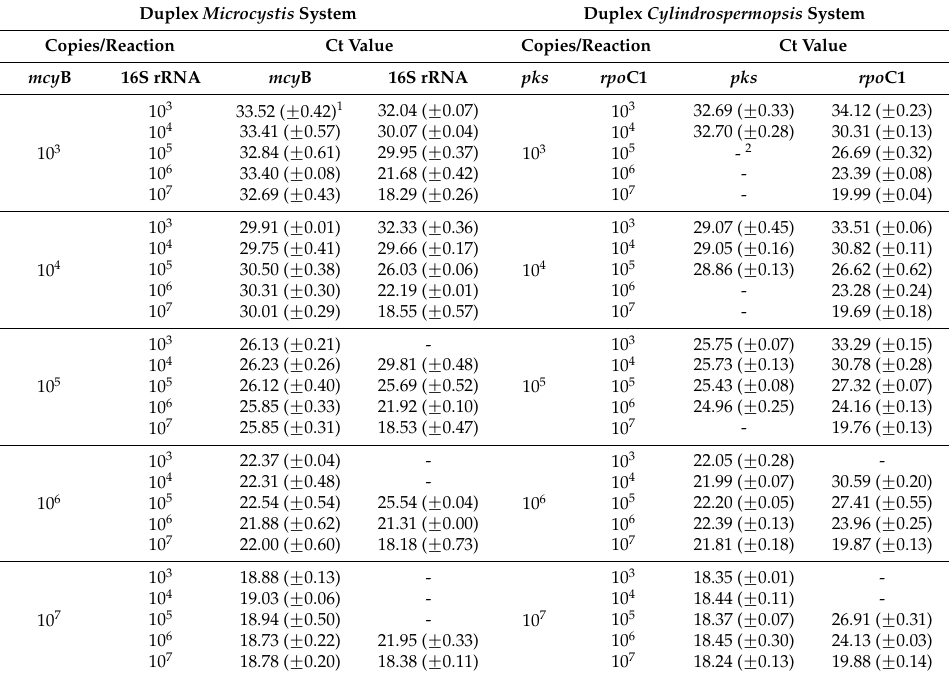
Table 2. Test of influence on gene detection using different amounts of standard